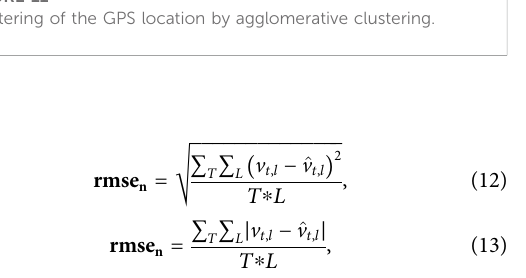
FIGURE 11 Clustering of the GPS location by agglomerative clustering.